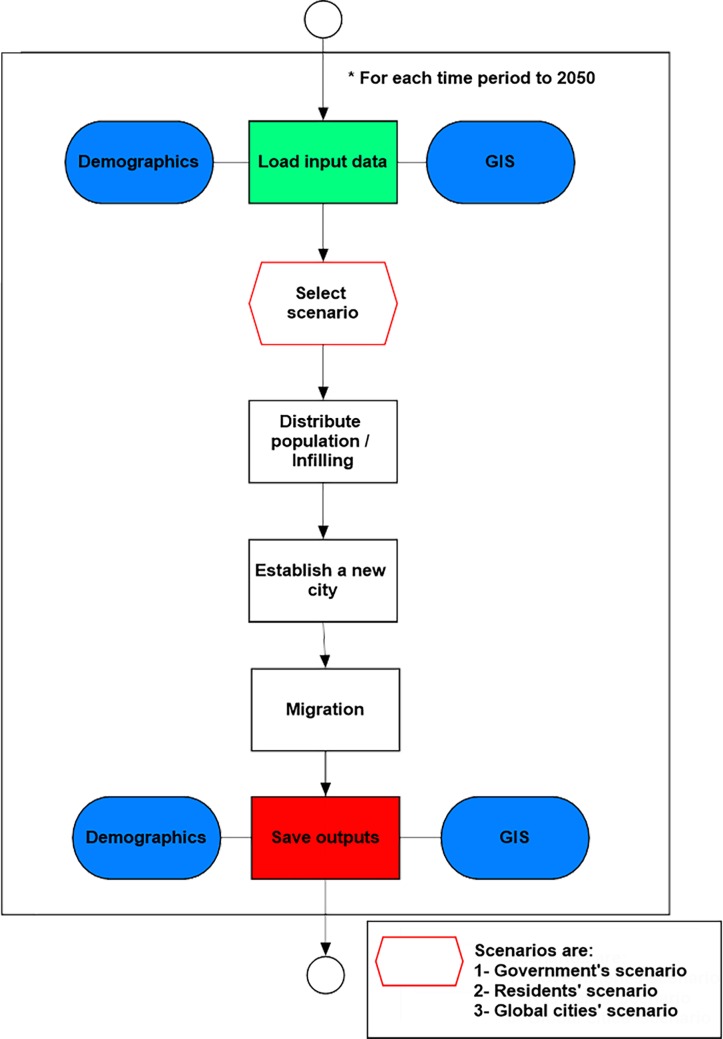
The model flowchart.